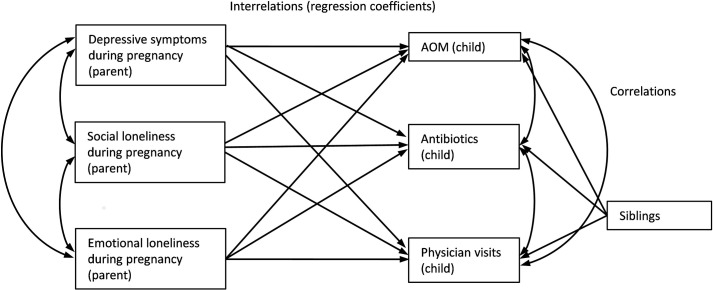
Hypothesized model.